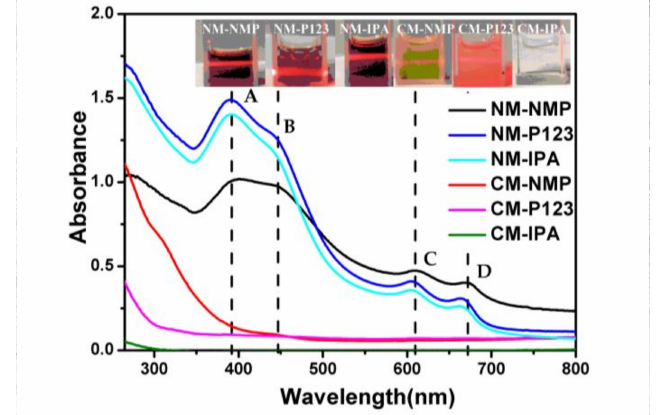
Figure 1. Ultraviolet-visible absorption spectra of products exfoliated in various solvents from natural molybdenite (NM) and commercial MoS 2 ( CM). The Photographs of different products with a red laser crossed through is shown in the